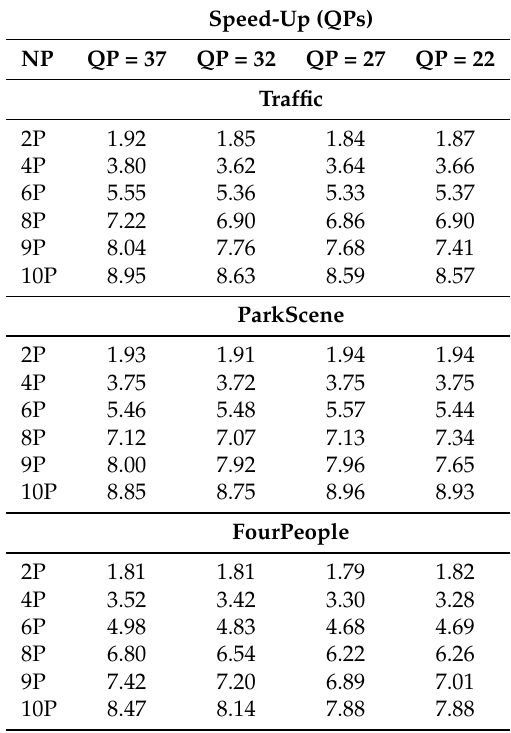
Table 4. Speed-up for the slice-based parallel